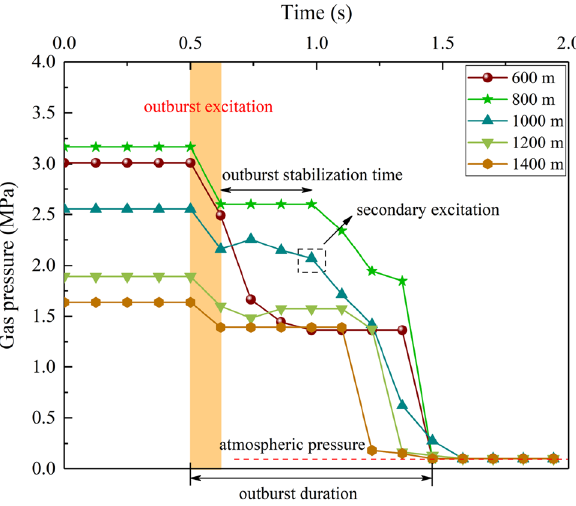
Figure 11. Variation of instantaneous gas pressure under different simulation